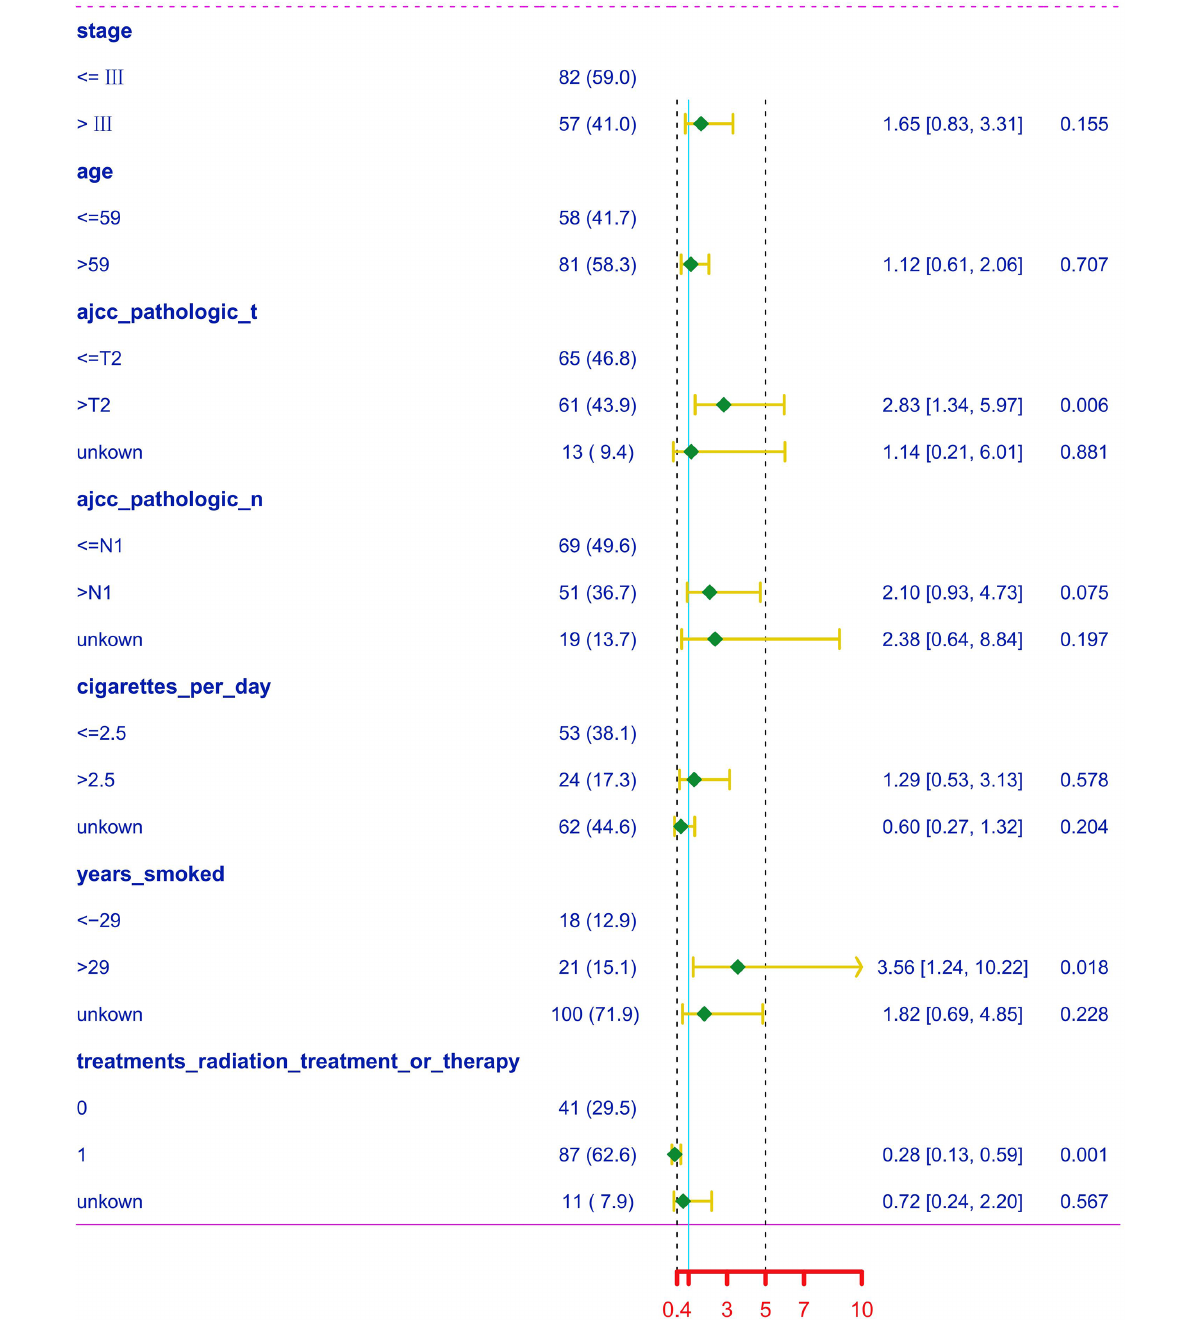
FIGURE 6 Multivariate COX regression of TSCC in the TCGA database for each clinical feature and